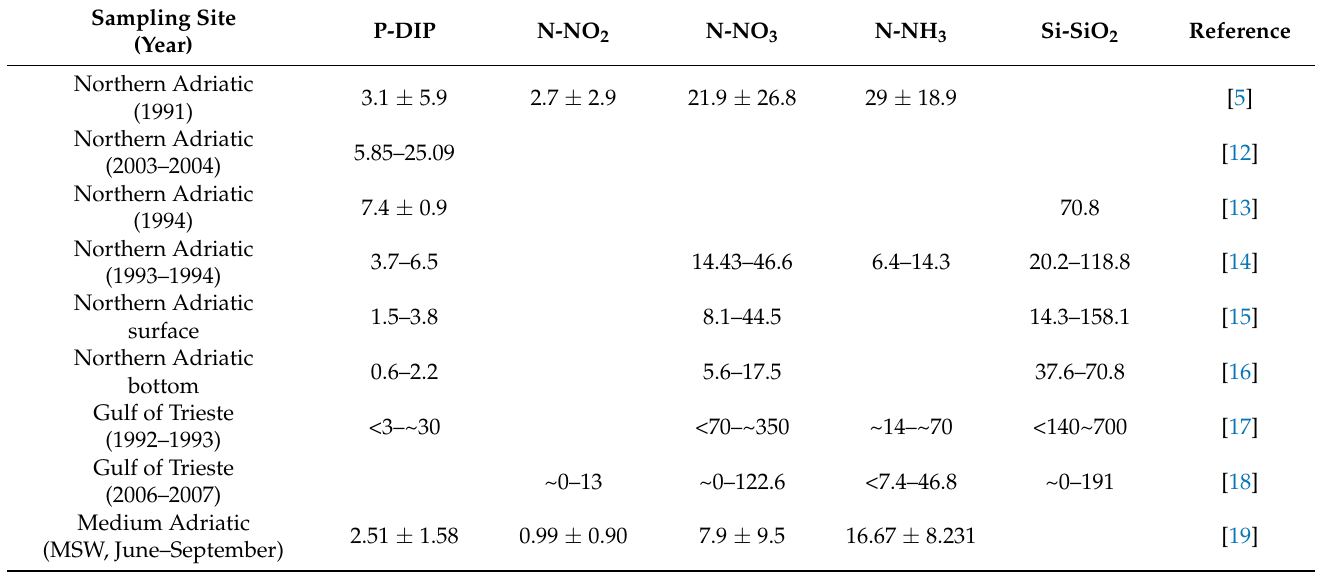
Table 1. Nutrients (ug/L) in Adriatic Sea from literature data.